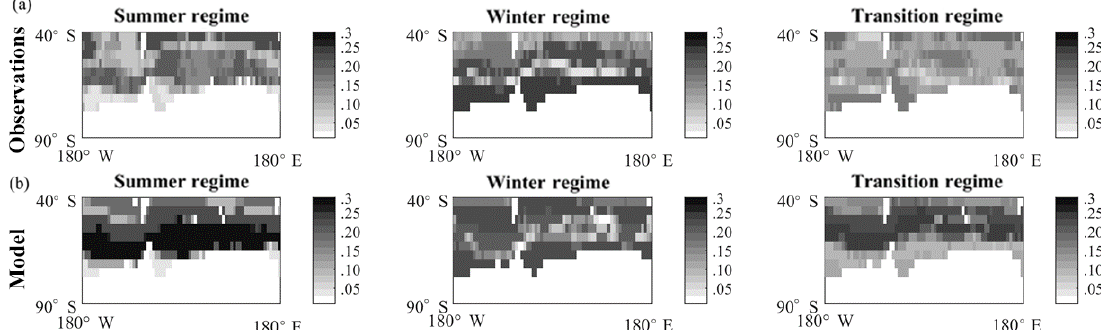
Figure 14. Regional attribution of each regime for k = 3 in the Southern Ocean in (a) the observations and (b) the GISS model simulations. Each spatial grid point for every month is associated with its relative frequency of occurrence in the cluster output, and then the months are averaged per regime to output the average frequency of occurrence in each regime. Model regimes are calculated using the monthly groups identified by the observations’ temporal attribution.